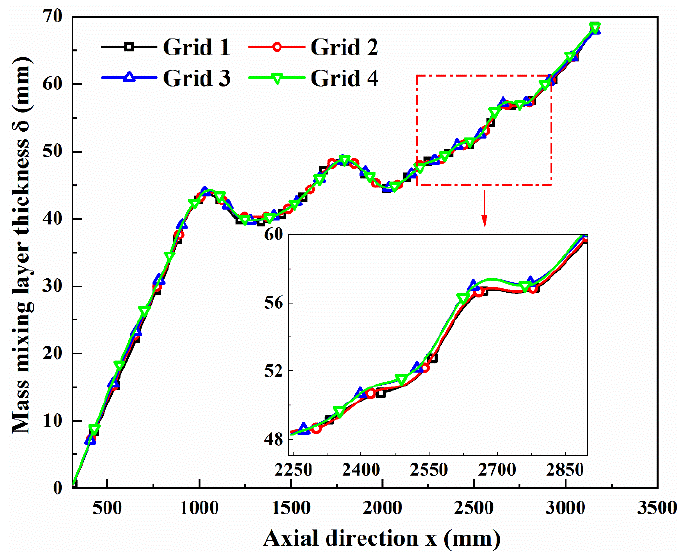
Figure 7. Mixing layer thickness at different grid numbers. Error accumulation is inevitable due to the finite grid size of successive time steps.